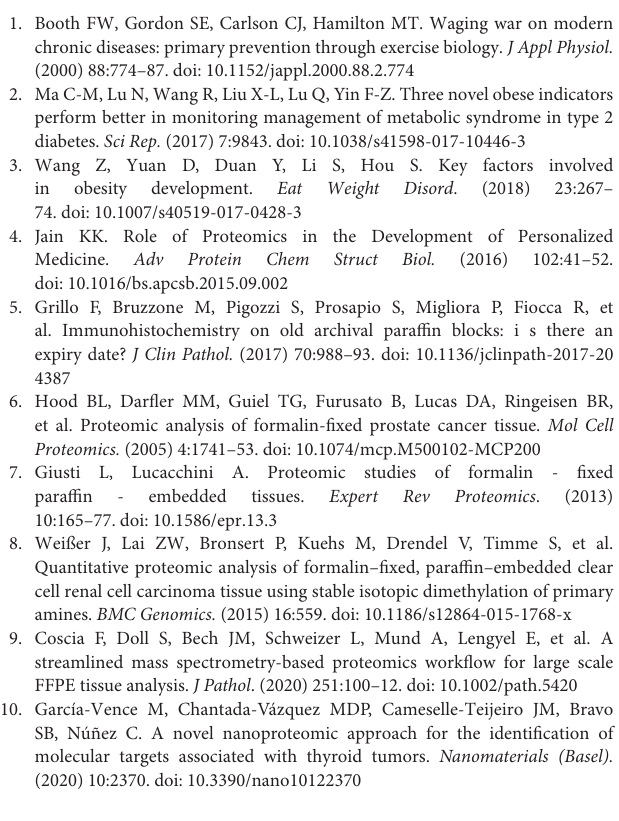
according to their biological process, molecular function and cellular component, using the FunRich program. Supplementary Table 4 | List of proteins and functional classification of the 896 and 21 unique proteins identified after the extraction with the five SDS-containing